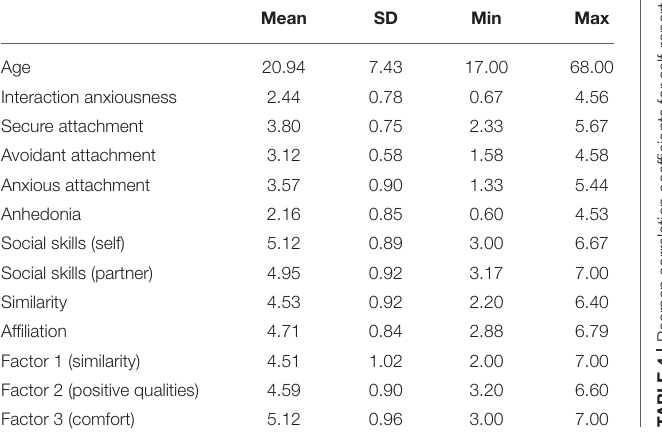
TABLE 3 | Summary of self-report variables for 65 stranger